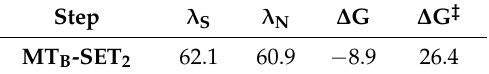
Table 2. Marcus theory-calculated values for the second SET step. Energies in kcal/mol. Step